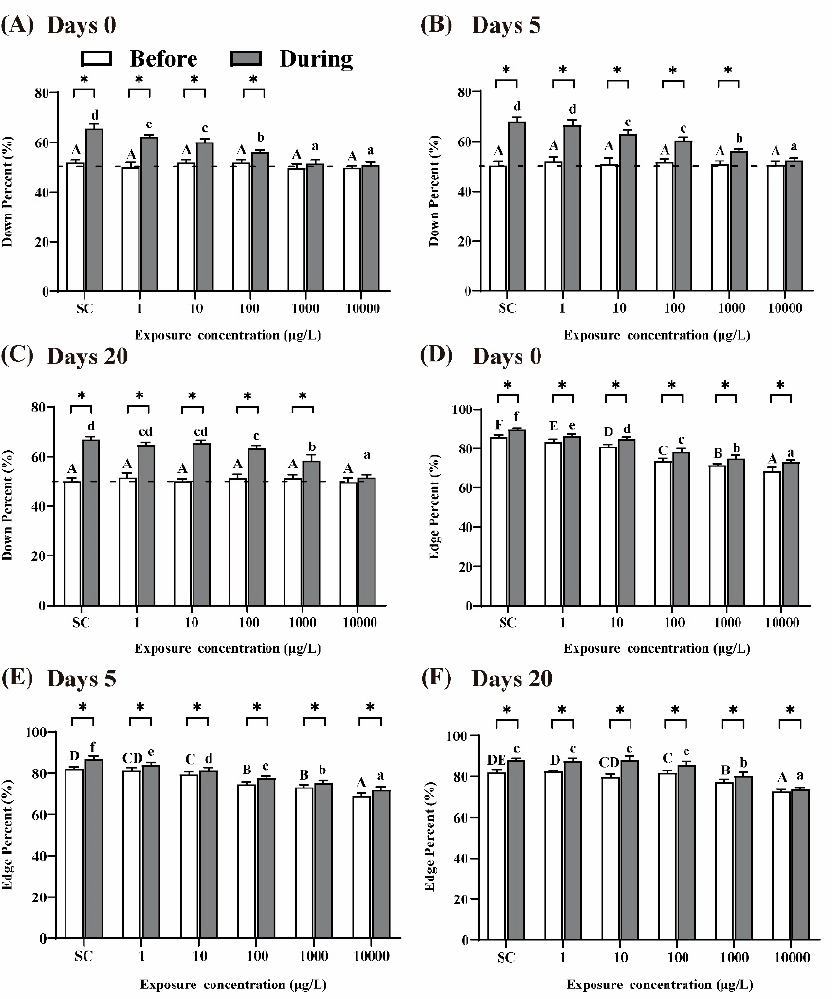
Figure 4. Avoidance behavior ( A – C ) and edge preference ( D – F ) of larvae at days 0, 5 and 20 of recovery. ‘Before’ and ‘During’ represent prior to the visual stimuli and in the presence of the visual stimuli, respectively. One-way ANOVA followed by Tukey’s post hoc tests were used to determine statistical differences. Capital letters and lowercase letters were labelled to distinguish ‘Before the visual stimuli’ and ‘During the visual stimuli’. Different letters indicate significant differences between different treatment groups ( p < 0.05). In the same group, asterisk indicates statistically significant difference between ‘Before the visual stimuli’ and ‘Before the visual stimuli’. ( p < 0.05). Independent-sample t -test was used to compare two independent